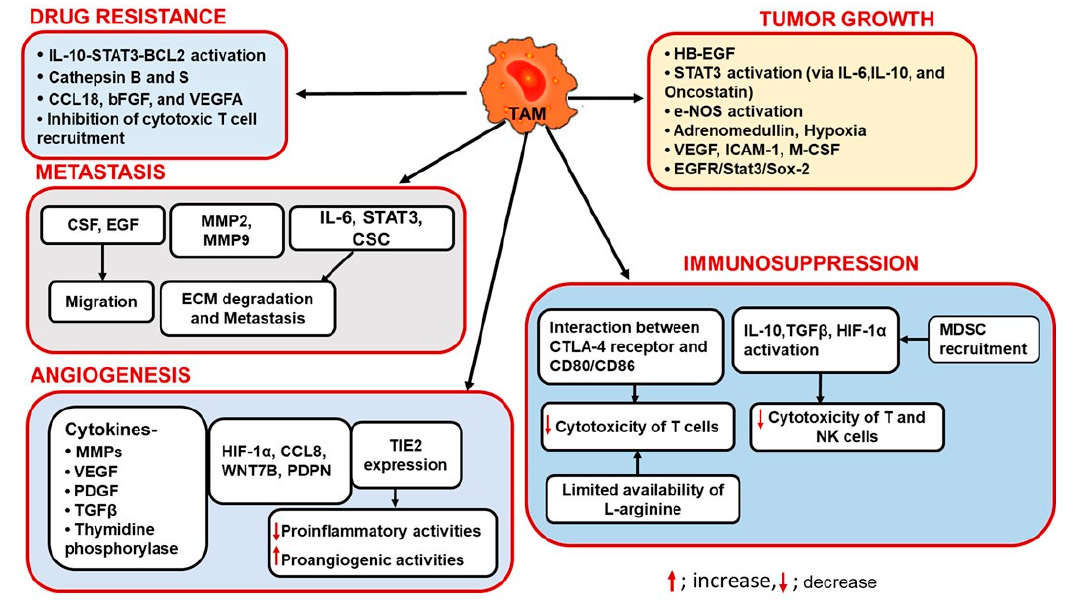
Figure 2. Multifaceted Roles of TAMs in TME. TAMS facilitate tumor growth by activating various signaling pathways including, signal transducer, and activator of transcription 3 (STAT3). The presence of M-CSF, IL-10, MMP9, and hypoxia assist TAMs in facilitating tumor growth. With tumor advancement, TAMs can either recruit immunosuppressive leukocytes or inhibit cytotoxic functions of immune cells in order to activate immunosuppression. Inhibition of cytotoxic T cell activities and recruitment causes drug resistance. Activation of the IL-10-STAT3-BCL2 pathway or cytokines and growth factors such as CCL18, basic fibroblast growth factor (bFGF), and VEGF in the TME further accelerates this TAM-mediated drug resistance. TAMs promote angiogenesis in the presence of cytokines such as MMPs and growth factors such as VEGF, PDGF, and TGF β . TAM-mediated activation of CCL8, WNT7B, PDPN, and TIE2 expression can also lead to angiogenesis in the TME. Once angiogenesis starts, tumor and TAMs together initiate extracellular matrix (ECM) degradation resulting in tumor migration and metastasis.